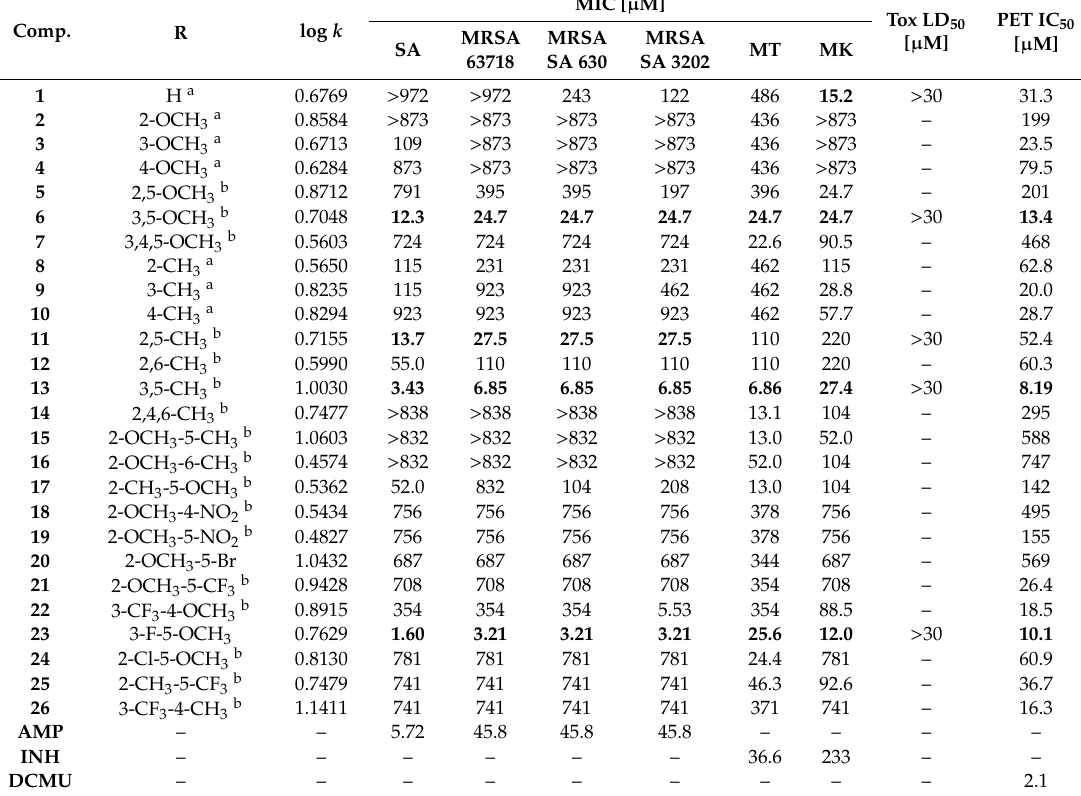
Table 1. Compositions of N -substituted 1-hydroxynaphthalene-2-carboxanilides, experimental log k values, in vitro antistaphylococcal activities MIC [ µ M] compared to ampicillin (AMP), in vitro antimycobacterial activities MIC [ µ M] compared to isoniazid (INH), in vitro cytotoxicity (Tox) assay (LD 50 [ µ M]) of chosen compounds and IC 50 [ µ M] values related to PET inhibition in spinach chloroplasts compared to 3-(3,4-dichlorophenyl)-1,1-dimethylurea (DCMU) standard. Comp.